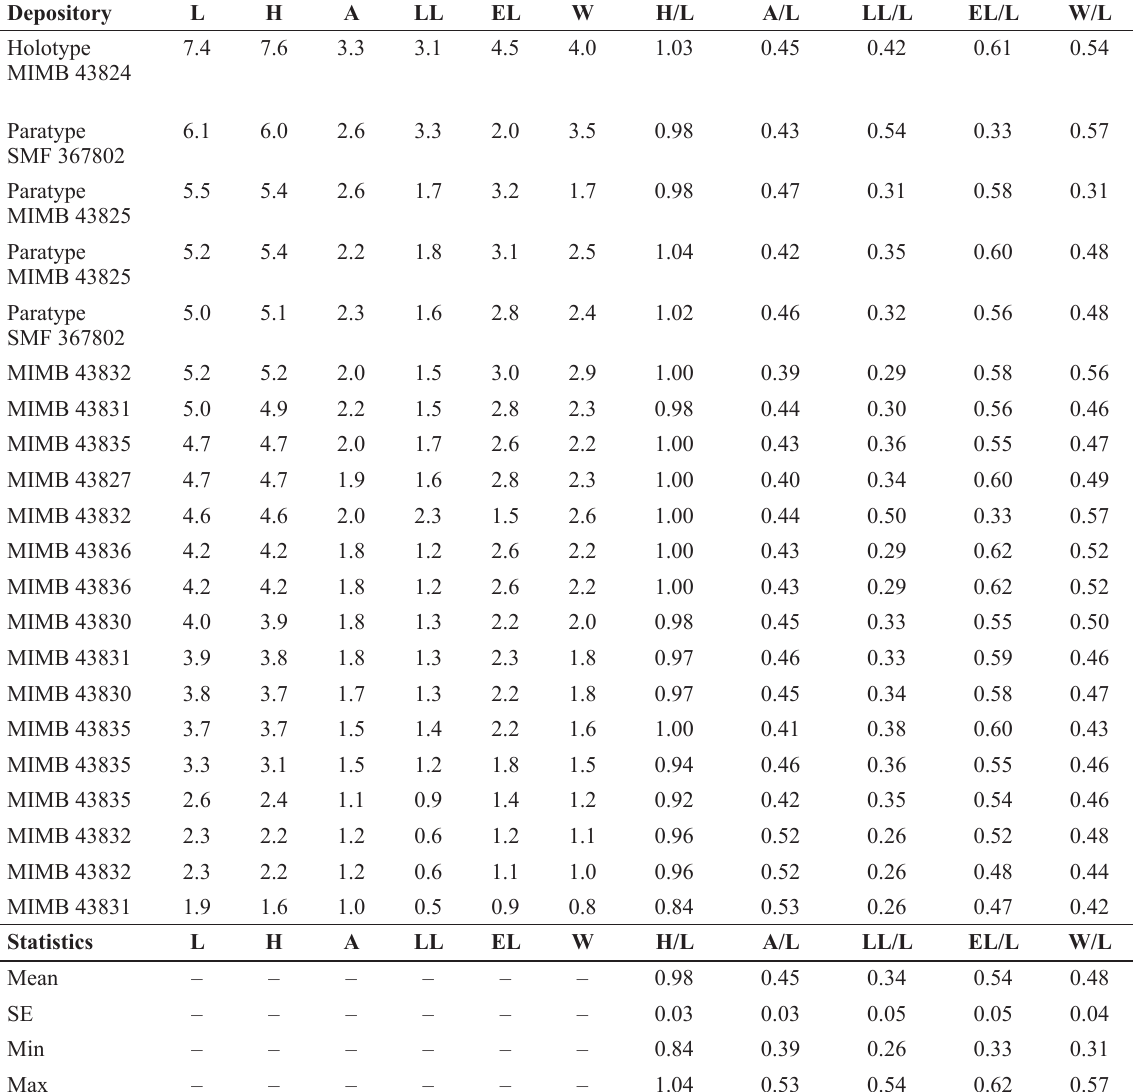
Table 4. Thyasira kharkovensis sp. nov., shell measurements (mm), indices and summary statistics of